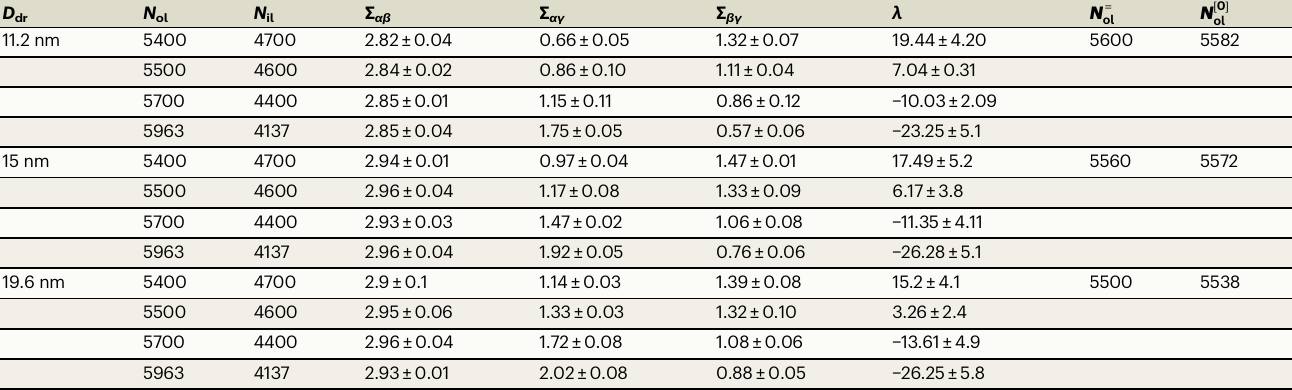
Table 1 | Numerical values of surface and line tensions corresponding to the data displayed in Figs. 6 and 7: Diameter D dr of droplets; lipid numbers N ol and N il in the outer and inner lea fl ets, encoding the transbilayer asymmetry of the nanovesicle as in Fig.2;interfacialtension Σ αβ ofliquid – liquidinterfacebetween α dropletand aqueous bulkphase β ;bilayertensions Σ αγ and Σ βγ of the two membrane segments αγ and βγ de fi ned in Fig. 1; as well as contact line tension λ